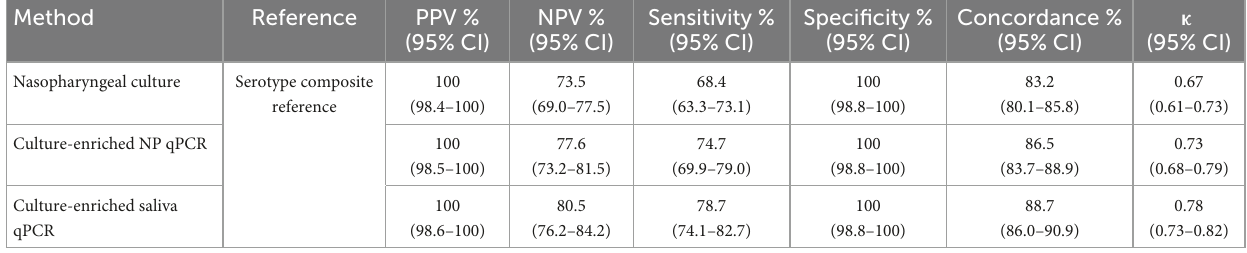
TABLE 4 The accuracy of Streptococcus pneumoniae serotypes detection in paired nasopharyngeal and saliva samples from n = 653 children in the Netherlands tested using molecular methods applied to DNA extracted from minimally processed and culture-enriched samples and applying ROCd C q thresholds for sample positivity in qPCRs.